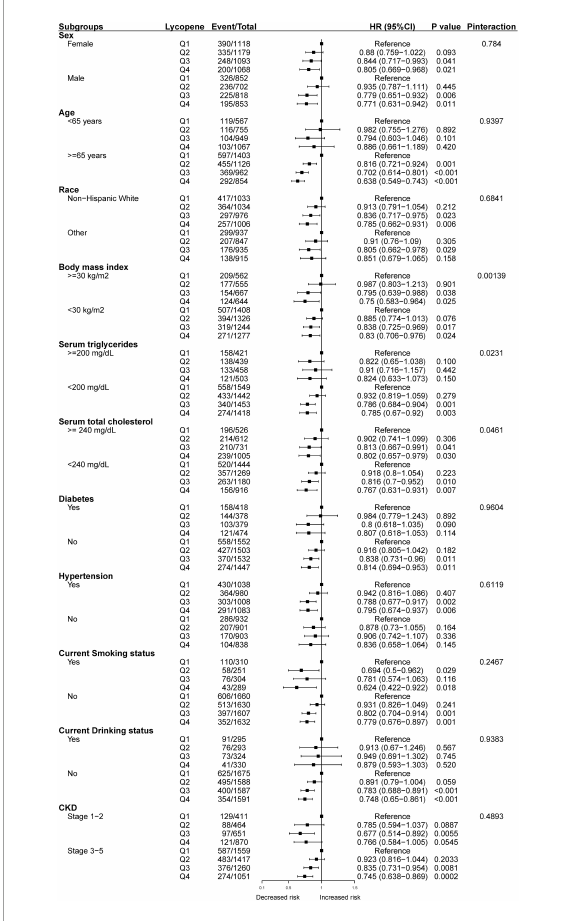
FIGURE4 Subgroup analyses of the association between serum lycopene concentrations and cardiovascular-cause